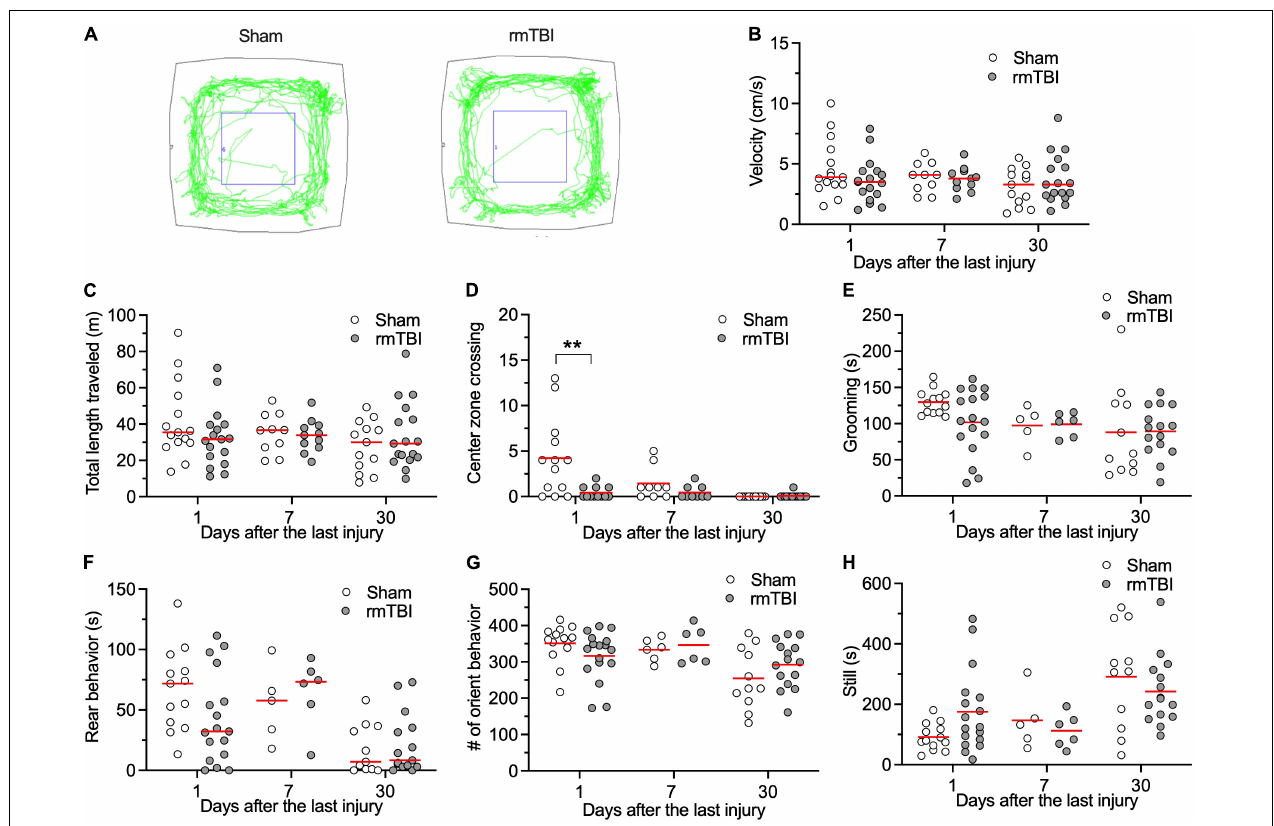
FIGURE 3 | rmTBI on behaviors in Behavioral Spectrometer test. (A) Sample tracks recorded from rats with sham injury (left) and rmTBI (right) . There is no difference in average velocity (B) , and total length traveled (C) between rats with sham injury and mTBI. Rats with rmTBI show transient reduced intent to cross the middle of the arena (D) . There is no difference in time on grooming (E) . Rats with rmTBI don’t show changed rear behavior (F) , orient behavior (G) , and total still time (H) . ** P < 0.01 by planned comparison with Bonferroni correction. Each dot represents data from one